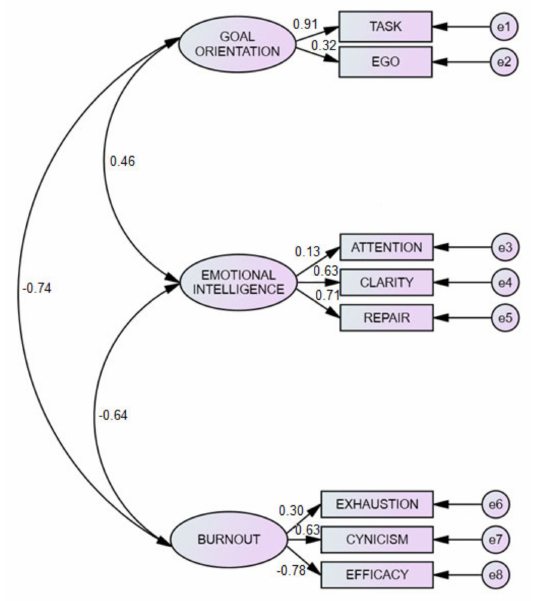
Figure 1. Goal orientation, emotional intelligence and academic burnout structural equation